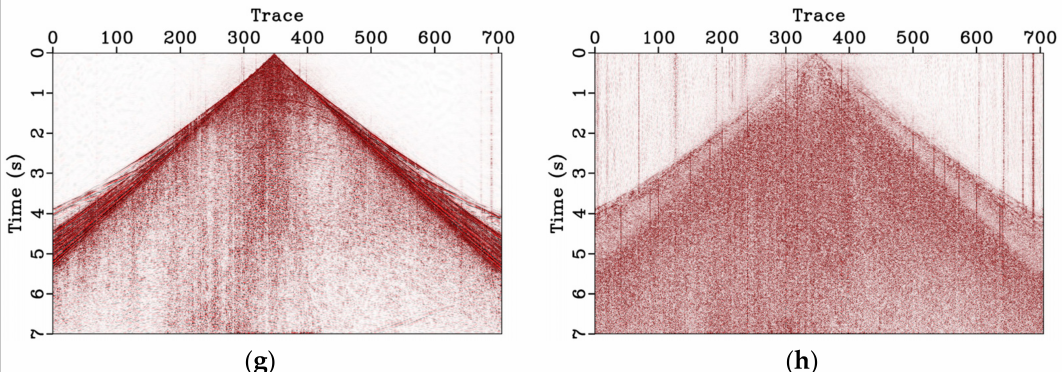
Figure 15. Land field data comparison of denoising performance. ( a ) The denoised results using f-x deconvolution. ( b ) Figure ( a ) corresponds to the removed noise. ( c ) The denoised results using the CS method. ( d ) Figure ( c ) corresponds to the removed noise. ( e ) The denoised results using the MF + FX method. ( f ) Figure ( e ) corresponds to the removed noise. ( g ) The denoised results using the proposed method. ( h ) Figure ( g ) corresponds to the removed noise.